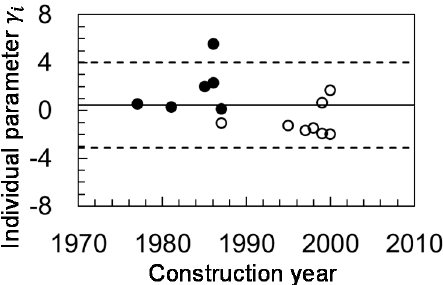
Figure 9. Relationship between bilge water amount and individual parameters. Opened and closed circles are plots for vessels with IBTS and without IBTS, respectively. Solid line is mean of individual parameters, and dashed lines are upper and lower limits of 90% confidence interval.